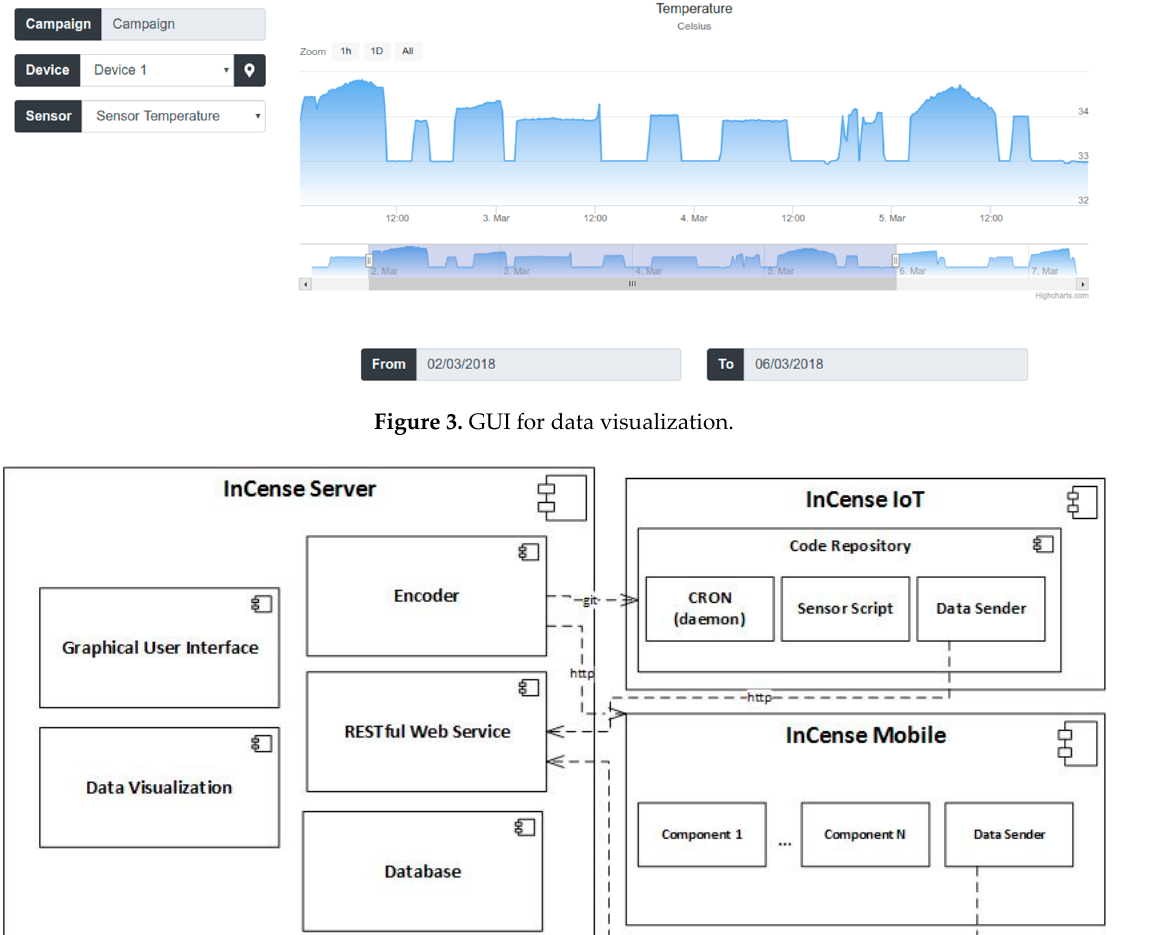
Figure 4. Extended InCense